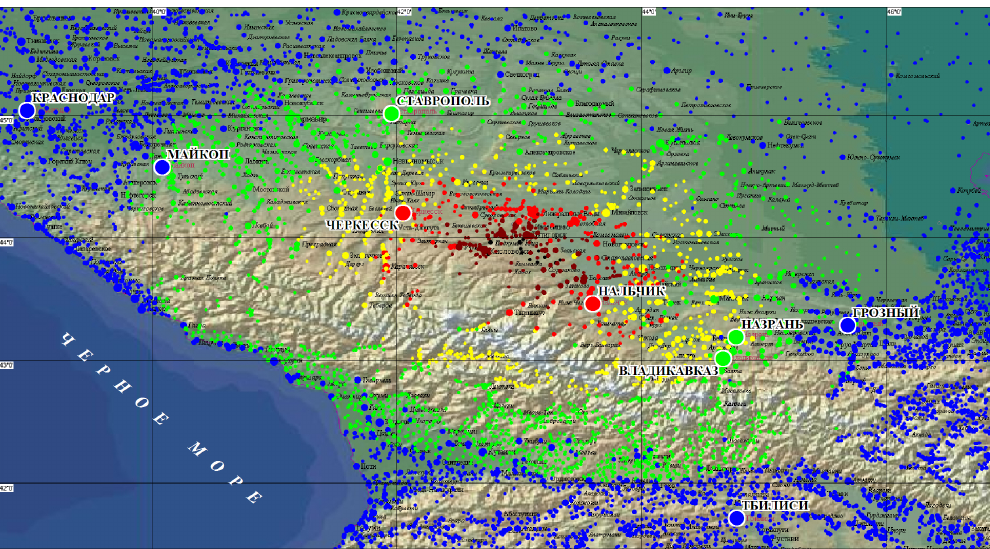
Fig. 5. Simulation of expected damage due to scenario event no. 1. Distribution of average damage states to building stock in settlements: black colour – total collapse, brown – partial collapse, red – heavy damage, yellow – moderate, green – slight, blue – no damage.